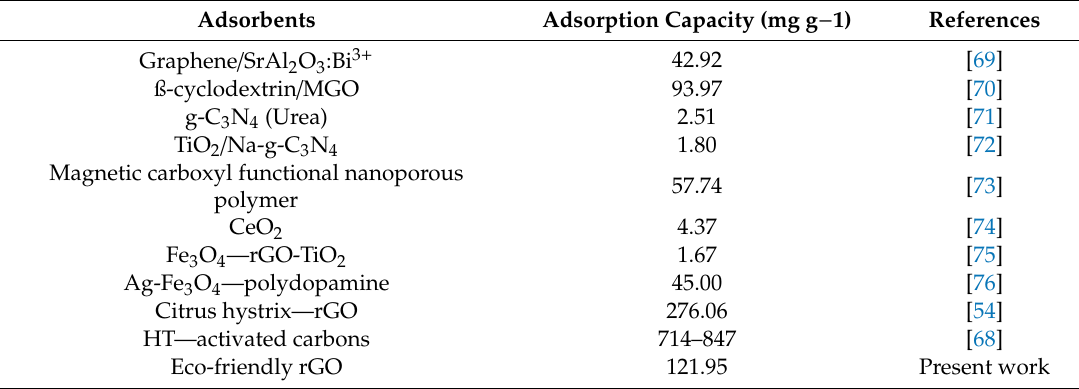
Table 4. Comparative adsorption capacity of several adsorbents for the removal of MB.